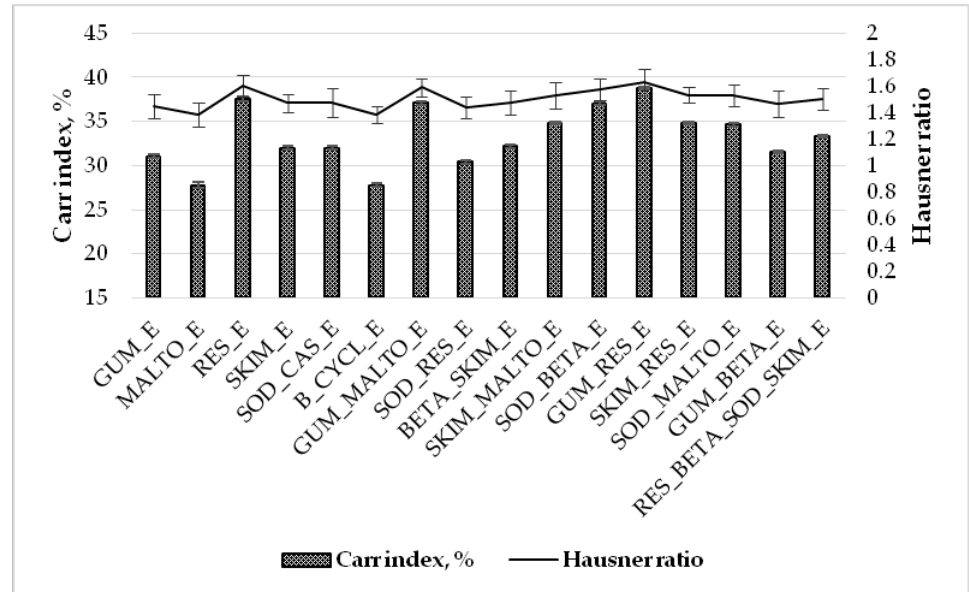
Figure 4. Carr index (%) and Hausner ratio of freeze-dried powders obtained using different wall Carr index (%) and Hausner ratio of freeze-dried powders obtained using materials and mixtures. di ff erent wall materials and